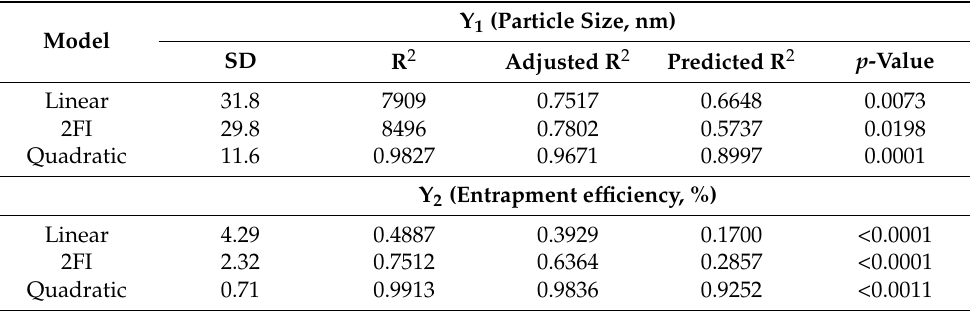
Table 3. Regression values of the selected responses during